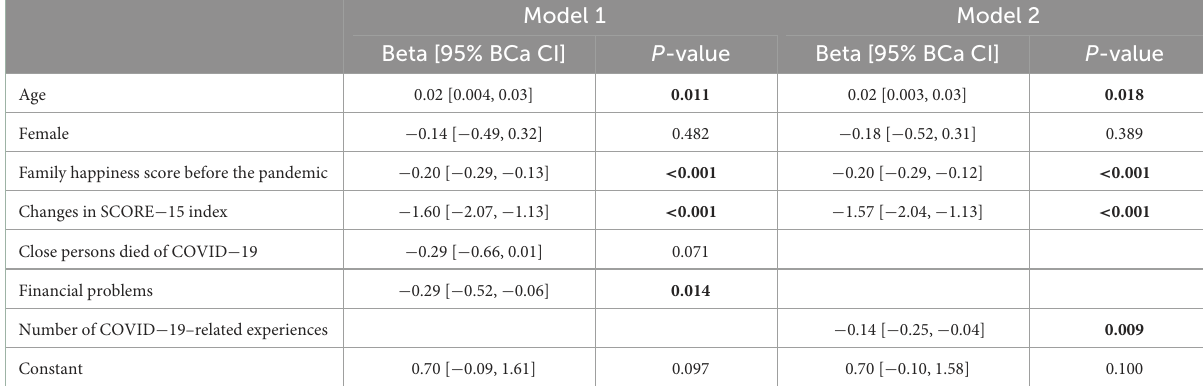
TABLE 4 Multiple linear regression of factors associated with changes in perceived family